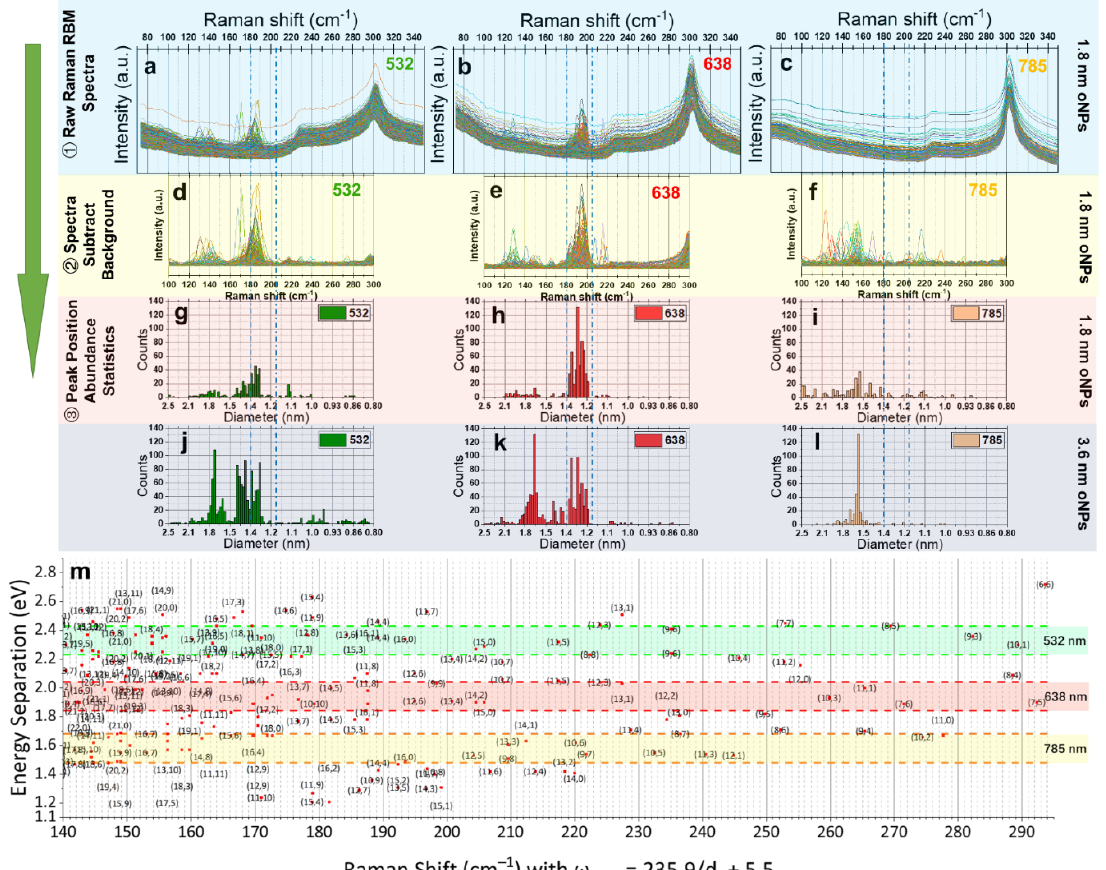
Figure 6. The comparison between constraint effects on the diameter of SWCNTs grown from Fe catalysts with different sizes. ( a – c ) Raw Raman spectra at the RBM region (70–350 cm −1 ) of SWCNTs grown from 1.8 nm Fe-oNPs detected by 532, 638, and 785 nm lasers. ( d – f ) The peak position of each spectrum is identified after background removal (SiO 2 /Si signal). The spectra tails around 290–300 cm −1 are generated during background removal; ( g – i ) for SWCNTs grown from 1.8 nm Fe-oNPs, the peak position abundance statistics obtained by different lasers are normalized by pixel number and laser spot area. ( j – l ) For SWCNTs grown from 3.6 nm Fe-oNPs, the normalized peak position abundance statistics. ( m ) Modified Kataura plot is used to identify the resonant chiralities. Regions of diameter from 1.18–1.4 nm are marked by dash-dotted lines.